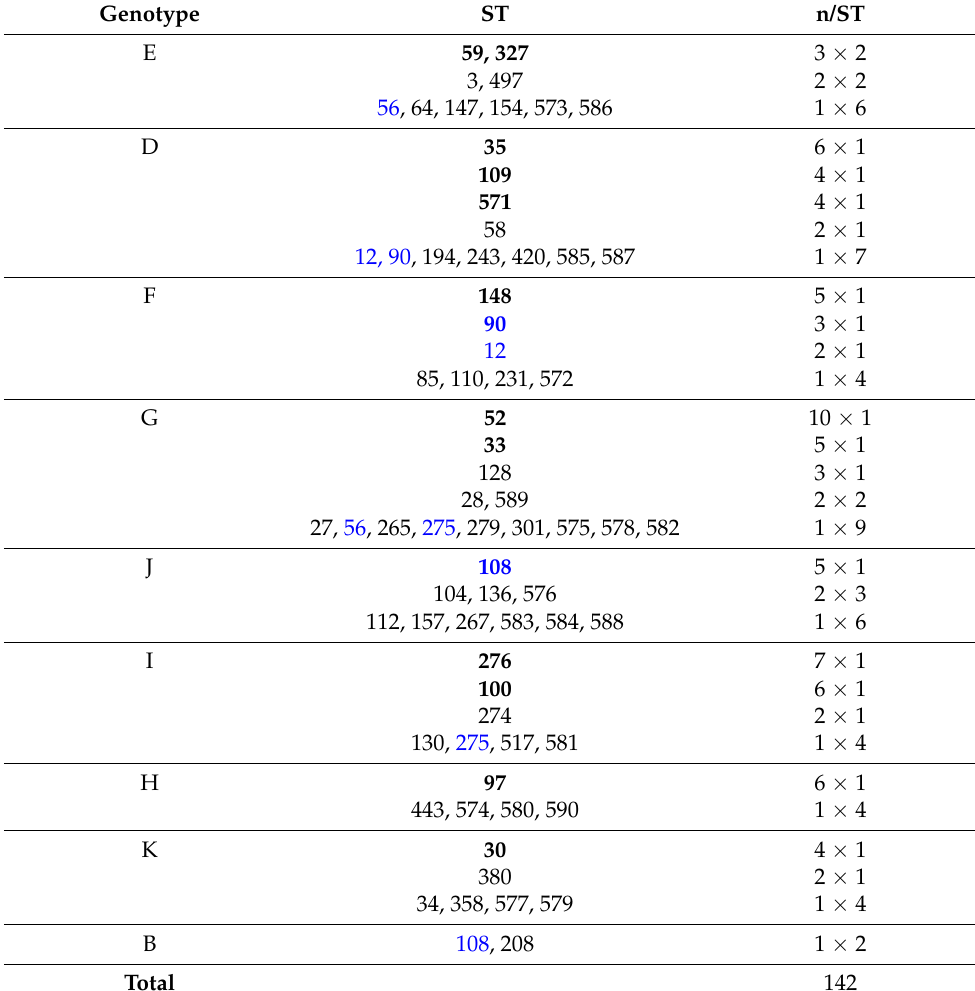
Table 3. Distribution of sequence types (STs) found in 142 selected samples from cases of Chlamydia trachomatis infection in Spain (2018–2019). Genotype ST n/ST E 59, 327 3 × 2 3, 497 2 ×